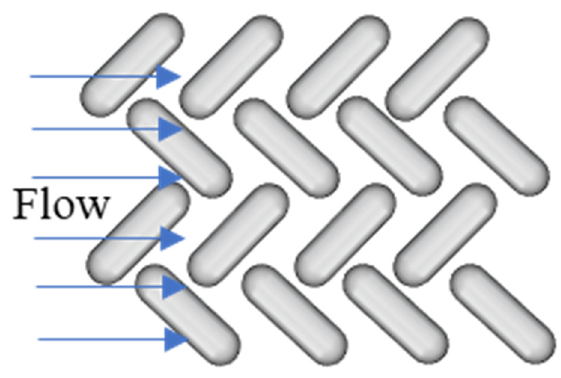
Figure 2. Illustration of the flow direction relative to the surface